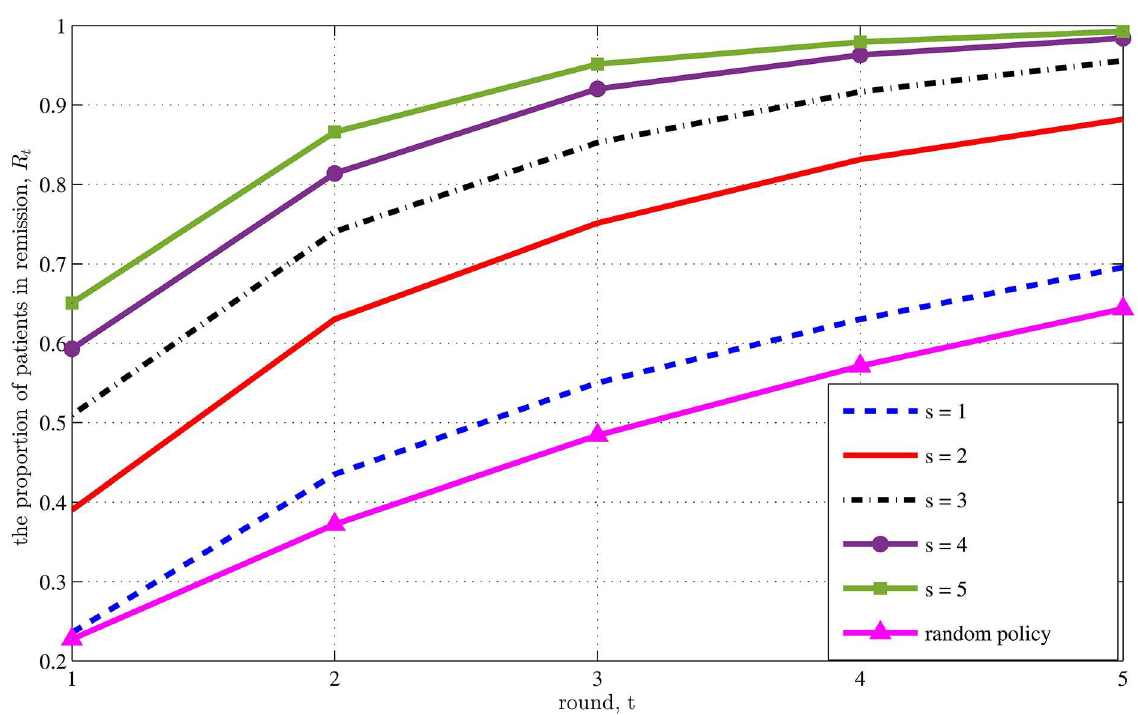
Fig 2. Results for the independence version of the problem with D 1 = 5 initial